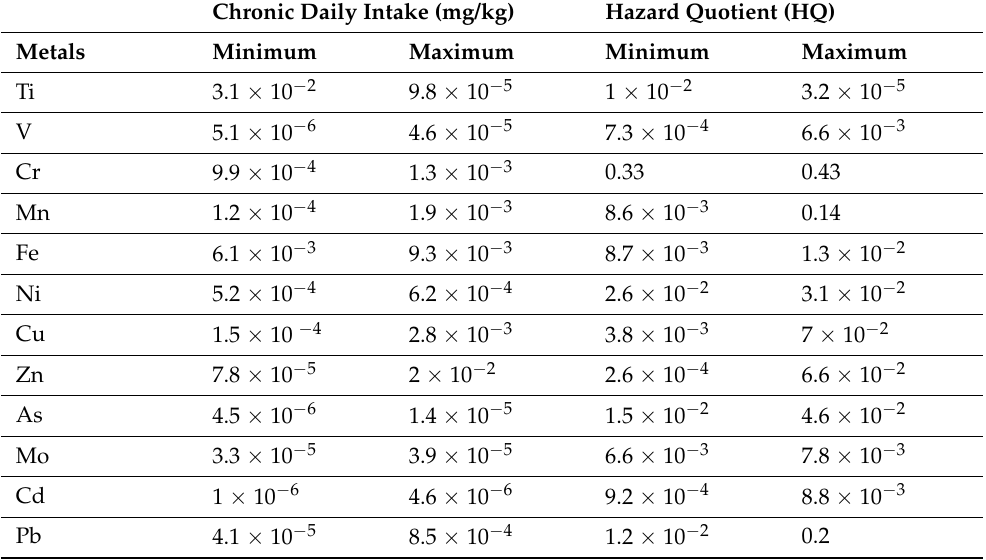
Table 3. Risk indices for daily intake and hazard